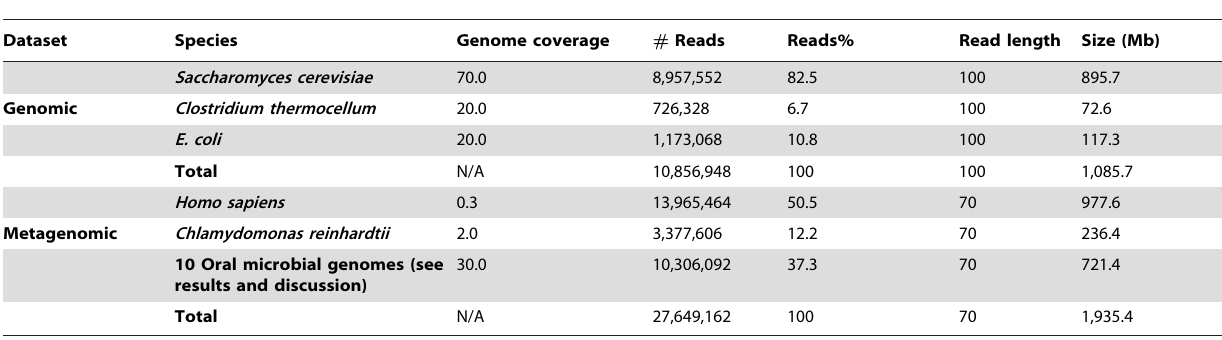
Table 1. Summary of the simulated data used in this study.